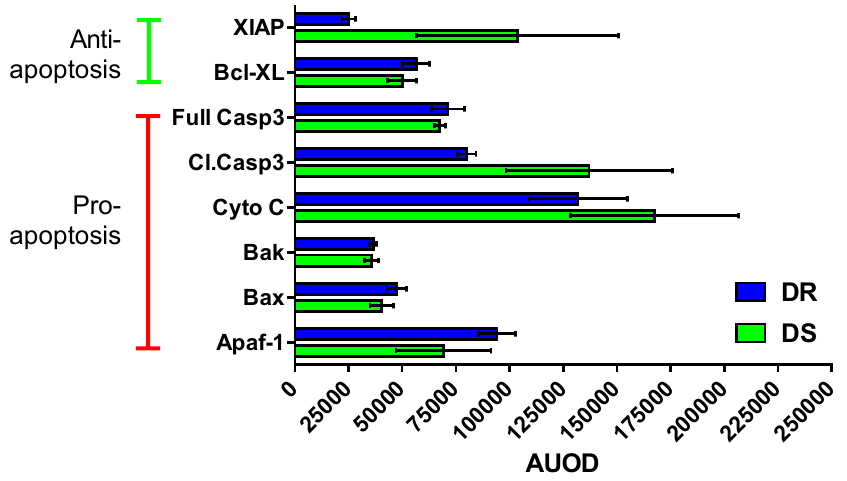
Figure 5. Expression levels (AUOD, arbitrary units of optical density normalized to GAPDH) for proteins involved in apoptosis. Tumors from dietary obesity sensitive (DS) and dietary obesity resistant (DR) rats were evaluated. Values are means ± SEM. Because expression of these proteins is interrelated, the overall impact of obesity status was evaluated by multivariate analysis techniques (Section 3.6.3).